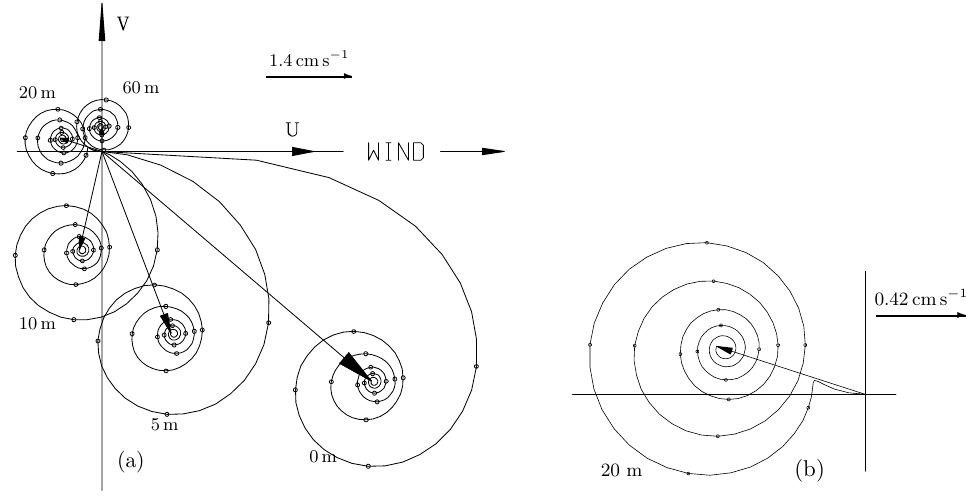
FIG. 3: Time series of the horizontal velocity components u (a) and v (b) in the rectangular basin subject to constant wind from West computed with constant vertical eddy viscosity ν v = 0 . 005m 2 s − 1 . The labels on curves stand for depth in meters.